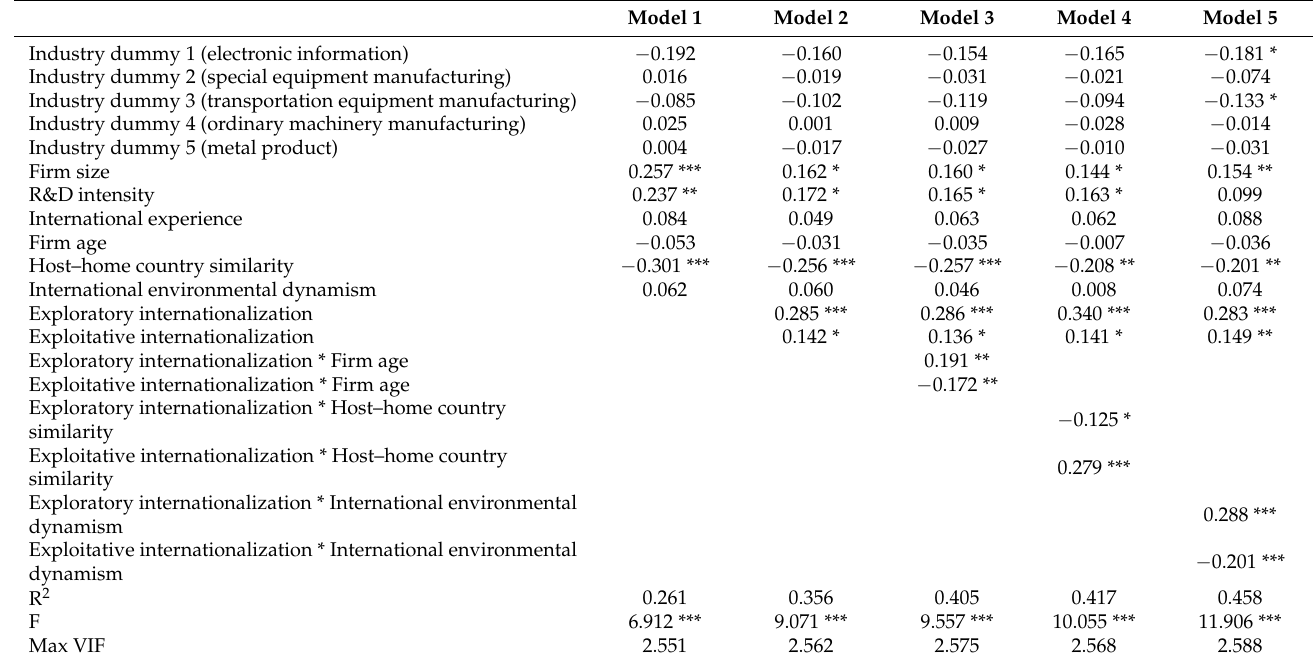
Table 4. Results of moderated regression